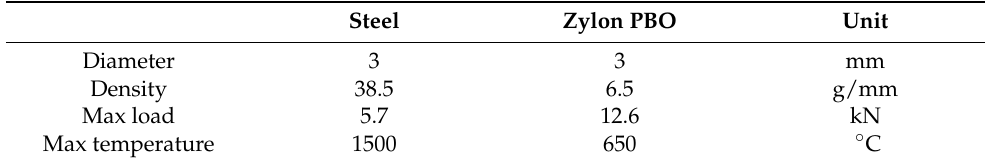
Figure 5. Detail of the spliced Zylon PBO cable connected to the anchor and tensioning system. Table 3. Comparison between steel and Zylon PBO